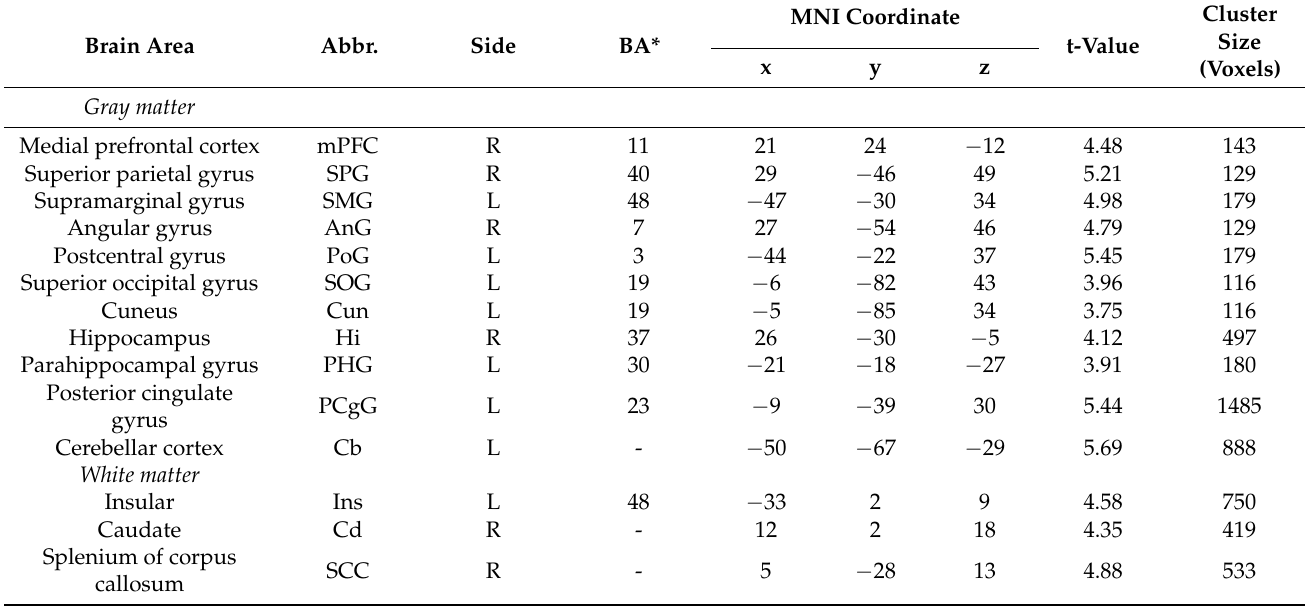
Table 2. Brain regions with a significant increase in GM and WM volumes in ICPP over age-matched controls (uncorrected; p < 0.001, excluded 100 voxels).